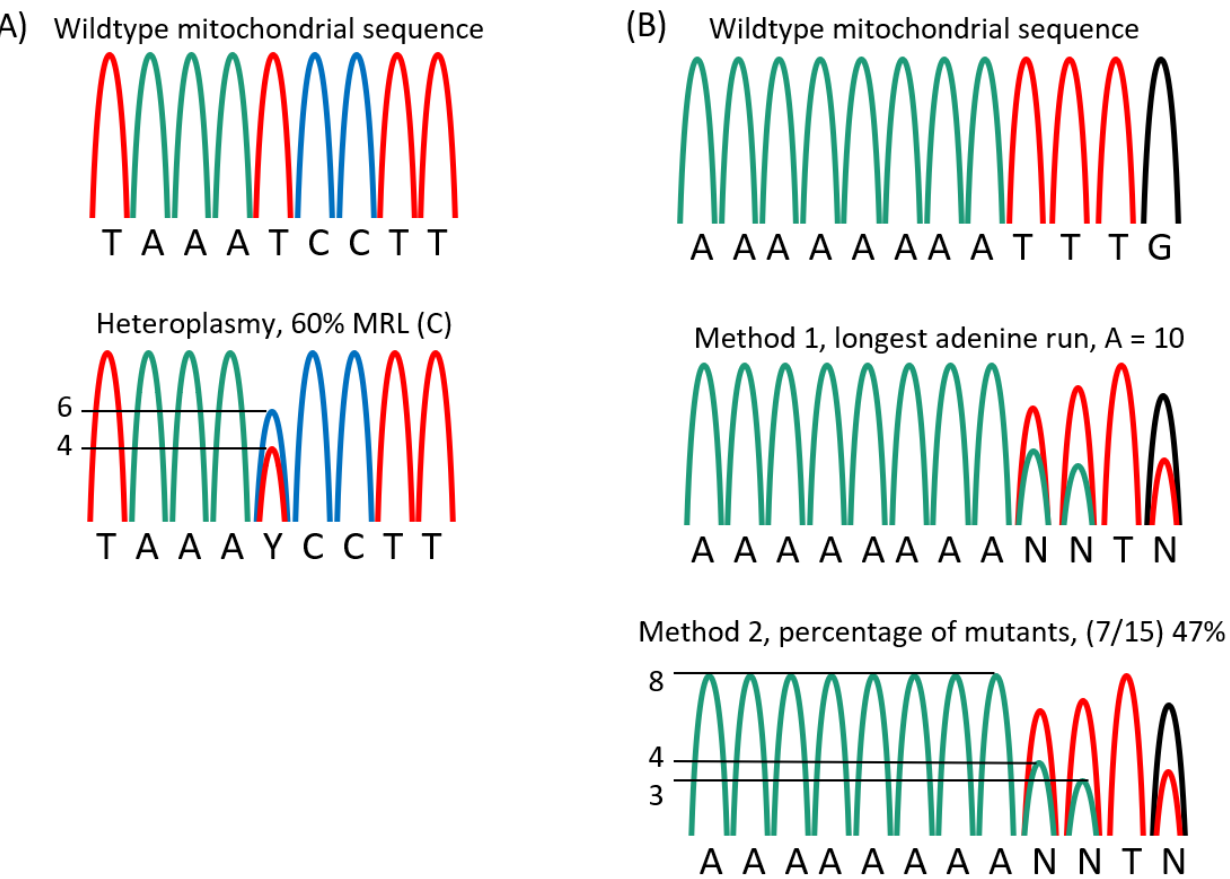
Figure 4. Mitotyping analysis. ( A ) Percent cytosine at position 3900 was measured from the nucleotide peaks of a standard sequencing application. ( B ) Adenine length was assessed as the last visible adenine peak or by measuring the height of the normal, ninth adenine, assigning this as 100% and comparing this to the sum of the longer adenine peaks (( Σ A 9–15 )/A 8 ) ×